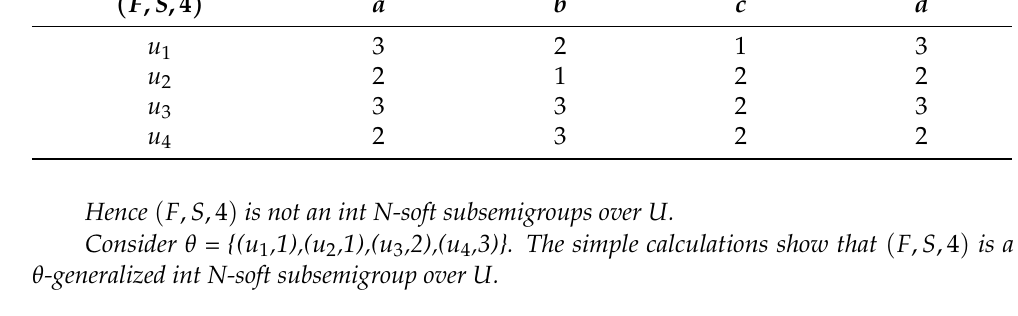
Table 14. The 4-Soft Set of ( F , S ,4 ) . ( F , S , 4 ) a b c d u 1 3 2 1 3 u